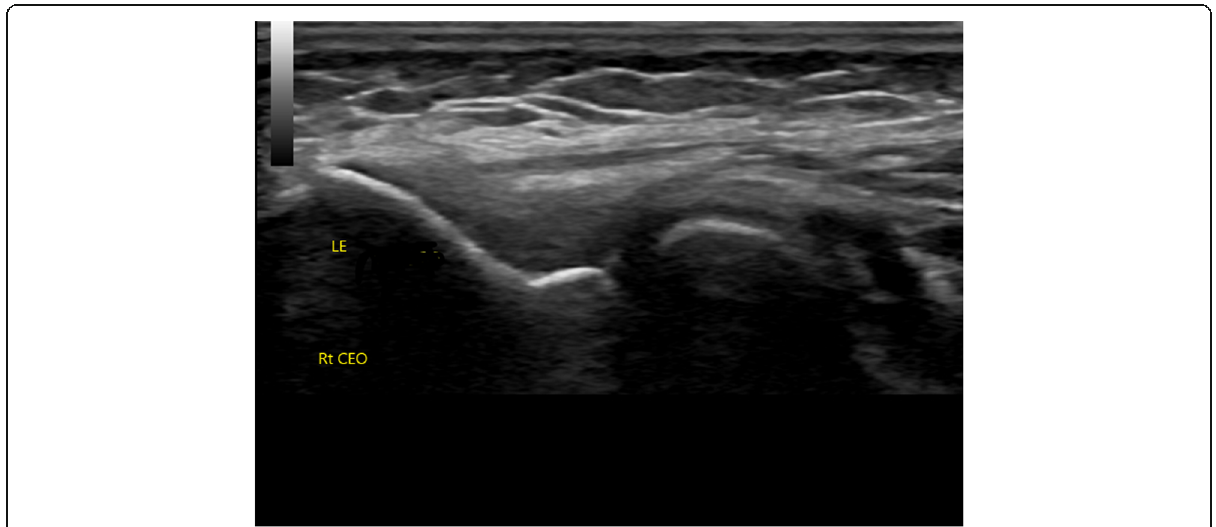
Fig. 5 US picture showing nearly normal fibrillar pattern of CEO of the same patient after US treatment. LE, lateral epicondyle; RT, right common extensor origin